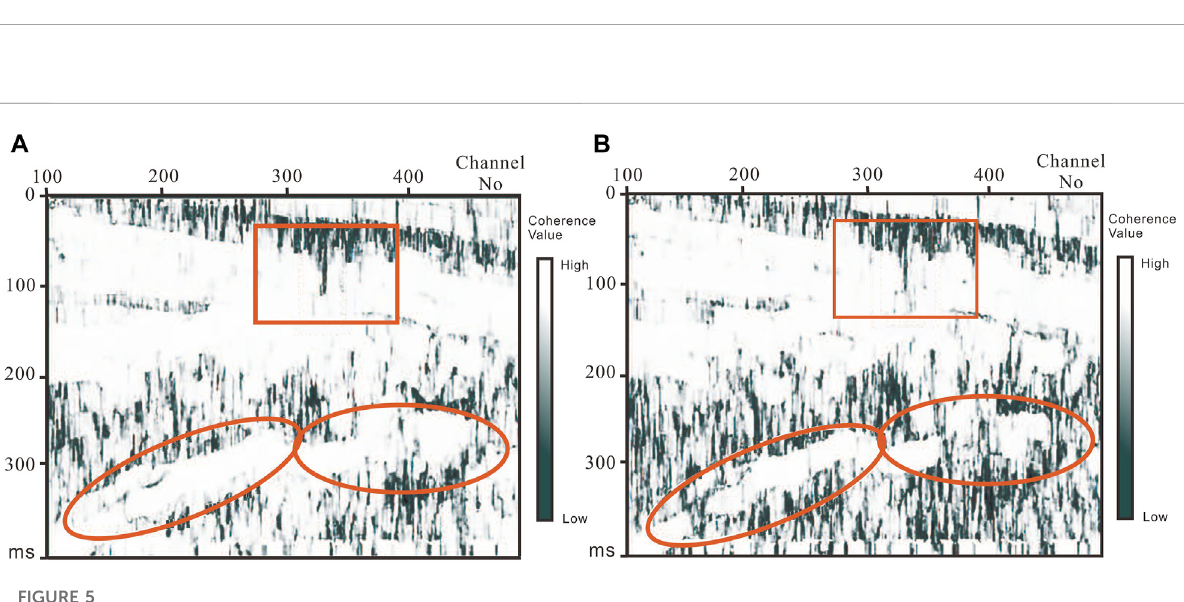
complex mathematical expressions. See (Terzaghi, 1965) for